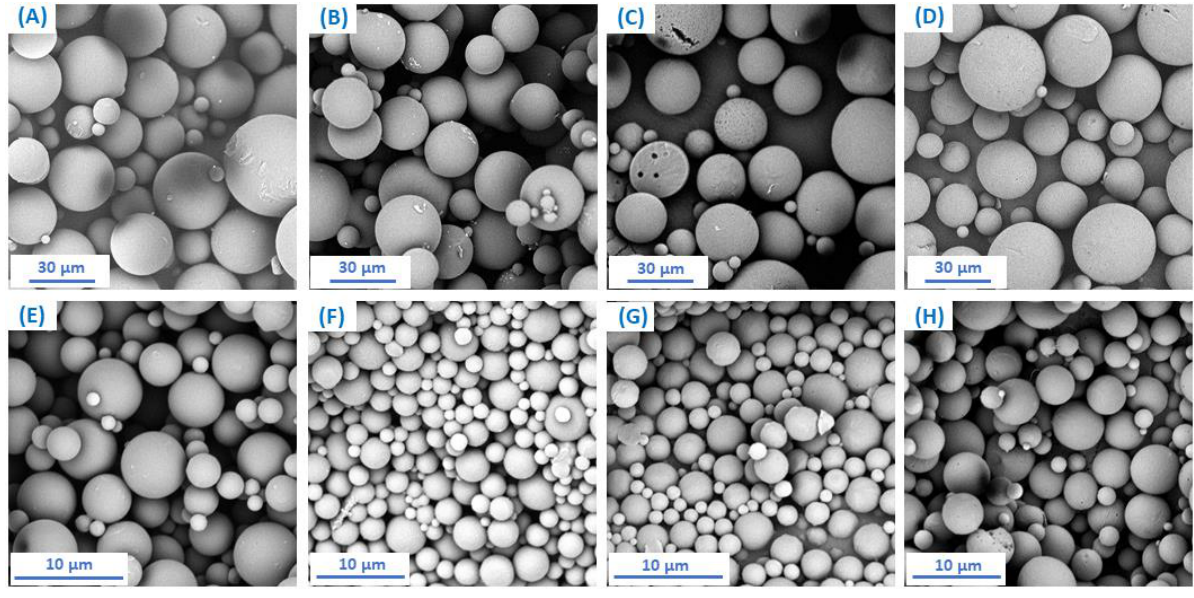
Figure 6. Scanning electron microscope (SEM) images of microspheres obtained from: DBB_SEB_20 ( A , E ); DBB_SEB_40 ( B , F ); DBB_SEB_60 ( C , G ) and DBB_SEB_80 ( D , H ), where ( A – D ) are large particles and ( E – H ) are small particles.